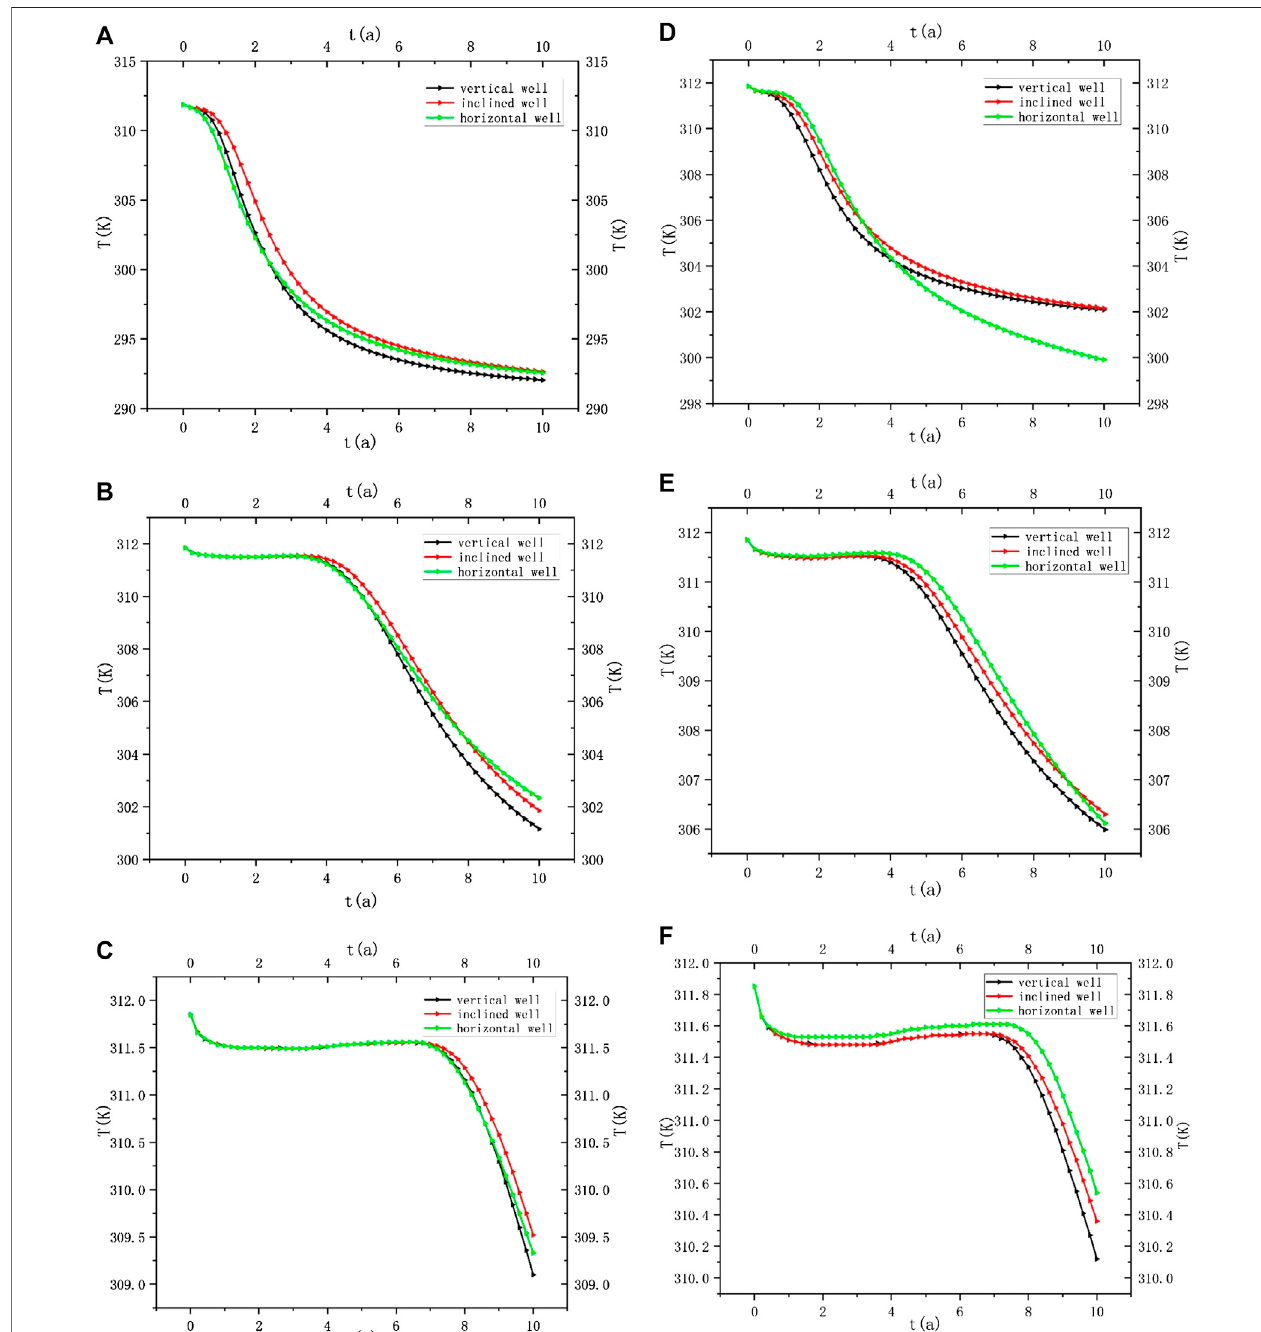
FIGURE 8 | Temperature changes of production wells under different reinjection well types. (A) Temperature change of one reinjection and one production with a well spacing of 100 m. (B) Temperature change of one reinjection and one production with a well spacing of 300 m. (C) Temperature change of one reinjection and one production with a well spacing of 500 m. (D) Temperature change of one reinjection and two production with a well spacing of 100 m. (E) Temperature change of one reinjection and two production with a well spacing of 300 m. (F) Temperature change of one reinjection and two production with a well spacing of 500 m.